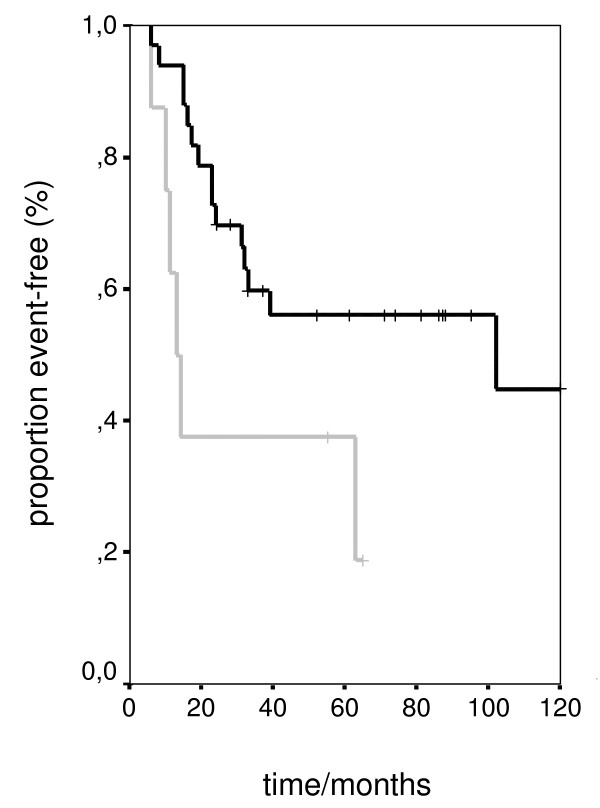
Overall survival for patients with preoperative (grey line) versus postoperative radiotherapy (black line).